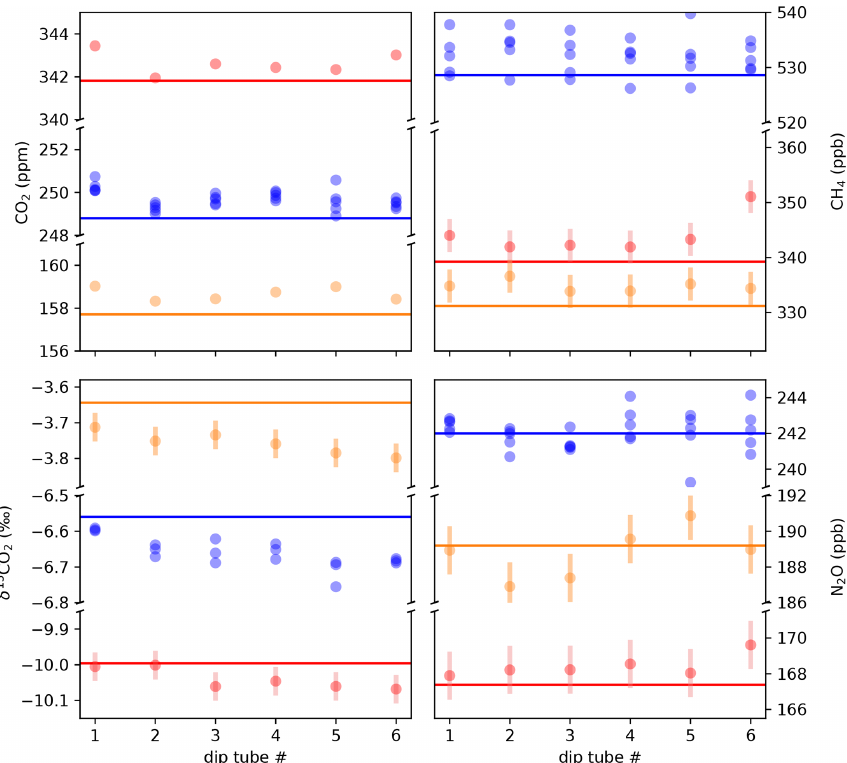
Figure 9. The standard-over-ice experiments characterize the small offsets that are introduced through the extraction process and gas transfer from the extraction vessel to the MPC. The standards no. 3 (orange) and no. 7 (red) were measured once each, while no. 1 (blue) was repeated five times. Error bars show the long-term reproducibility of discrete standards measured by the QCLAS only, as determined in Fig. 8. For standard no. 1, the error bars are omitted to improve legibility. For CO 2 , the error bars are smaller than the marker